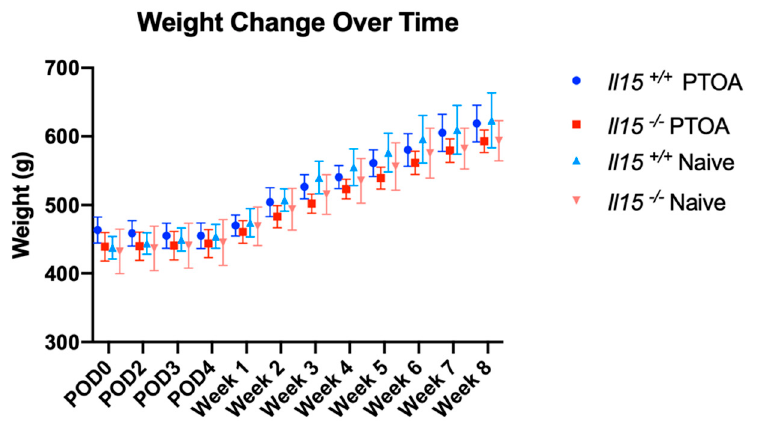
Figure 2. All groups gained weight similarly over the 8 weeks. Weight, in grams (g), was measured daily for the first 4 days post-operation, and then weekly for 8 weeks. A two-way ANOVA with repeated measures and Tukey’s multiple comparison was run post-hoc. There was no significant difference between the groups at any timepoint, with all groups steadily gaining weight throughout the experiment. (N = 15 rats/PTOA group, and N = 9 rats/Naive group, p > 0.05, data represented are mean with 95% CI).